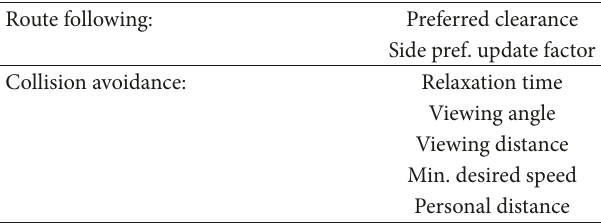
Table 1: The seven parameters included in the sensitivity analysis. Route following: Preferred